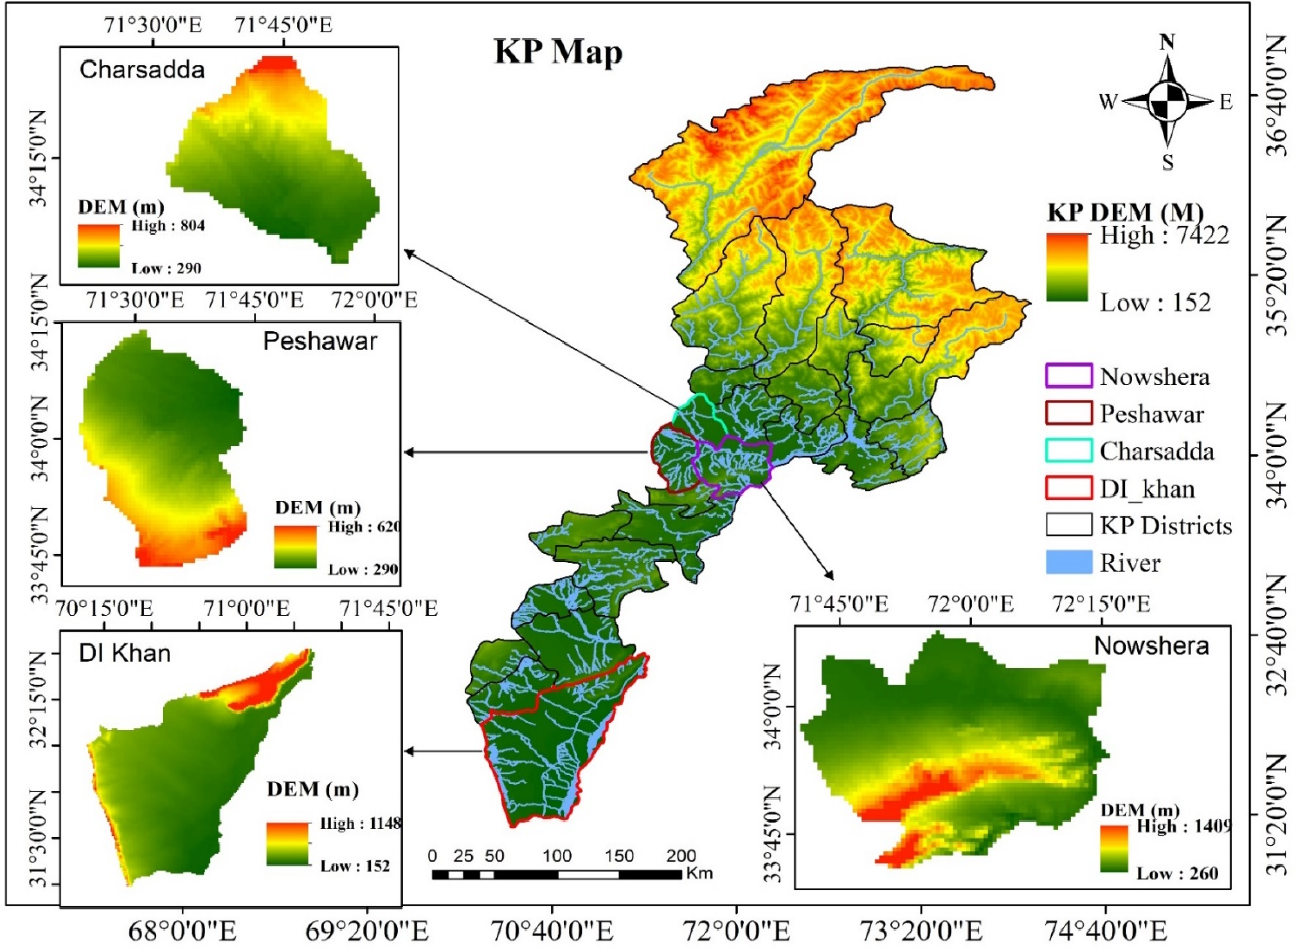
Figure 1. Sample study districts in Khyber Pakhtunkhwa Province, Pakistan.